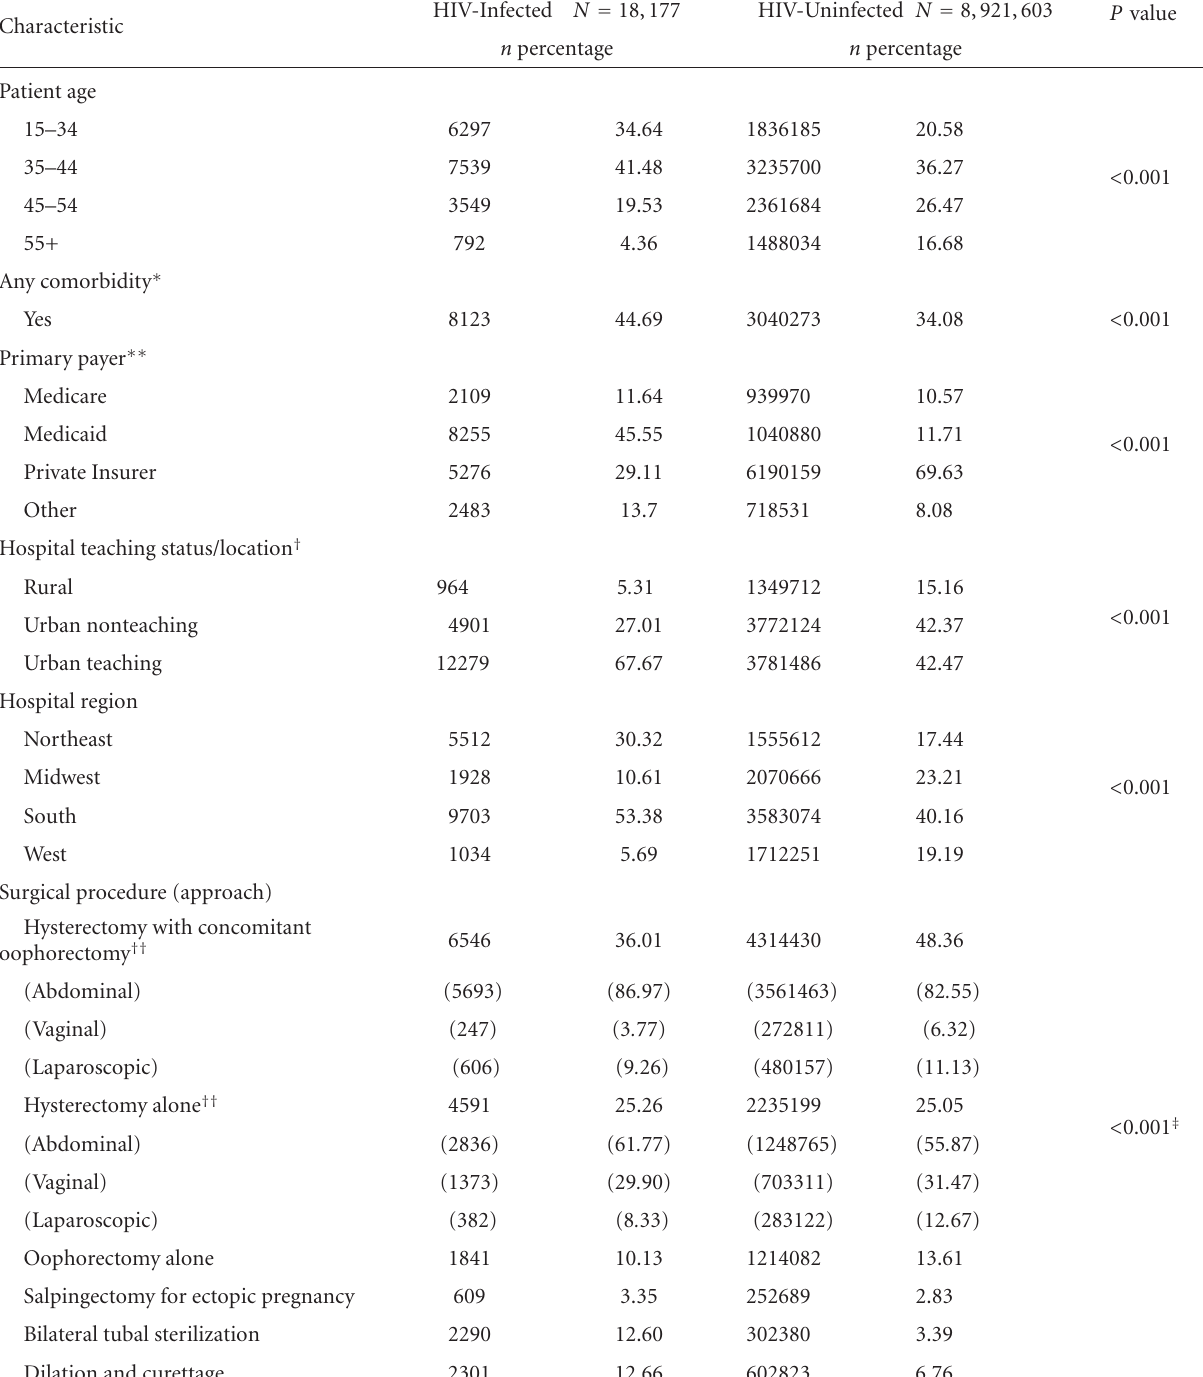
Table 1: Demographic and hospitalization characteristics, surgical procedure and approach, and presence of comorbidity among selected gynecological surgeries, by HIV status (United States,